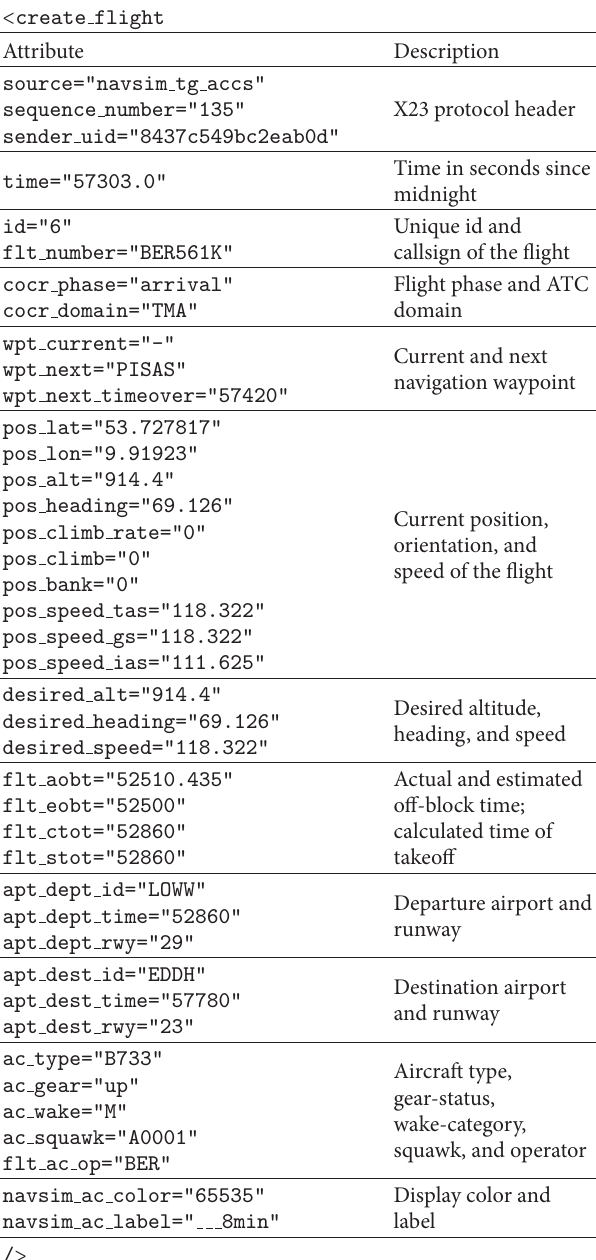
Table 2: The flight BER561K is created in the simulation approxi- mately eight minutes before arriving at